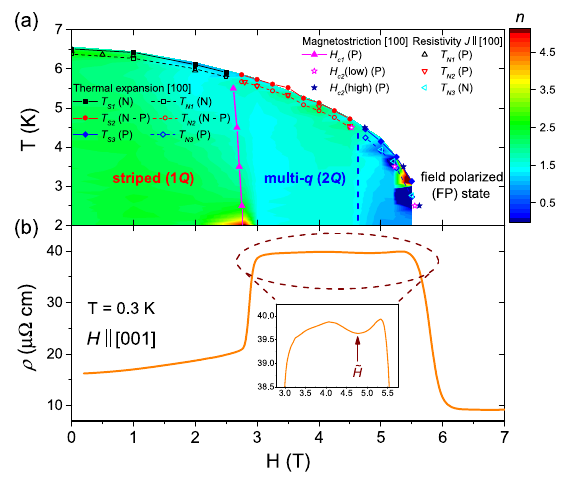
Fig. 1 Phase diagram of CeAuSb 2 its unusual magnetoresistance. a Temperature – magnetic fi eld phase diagram of CeAuSb 2 . The legend identi fi es how transition temperatures and fi elds are obtained. The solid squares, circles, and diamonds indicate the higher transition temperature T s in three regions. The open squares, circles, and diamonds indicate the lower transition temperature T N in three regions. The solid triangles indicate the fi rst critical fi eld H q and multi- q phases. The open and c 1 separating single- solid stars indicate the lower and higher second critical fi elds, respectively. The open up triangles, down triangles, and left triangles indicate T N in three regions. The sign of the peaks in the derivative are indicated in brackets: N negative, P positive. Colors represent the local exponent, n ¼ ∂ ln Δ ρ = ∂ ln T and Δ ρ = ρ ab − ρ 0 = AT n . The contour map shows the presence of three distinct regions in the phase diagram; the green, light-blue, and deep-blue regions denote the single- Q stripe phase (1 Q ), multi- Q phase (2 Q ) below ~ H , and multi- Q phase (2 Q ) above ~ H . Dashed vertical line inside 2 Q phase denotes a crossover boundary at ~ H . b Electrical resistivity as a function of applied fi eld along the c -axis. The inset shows an anomaly at the crossover fi eld ~ H . Error bars are smaller than the size of the data